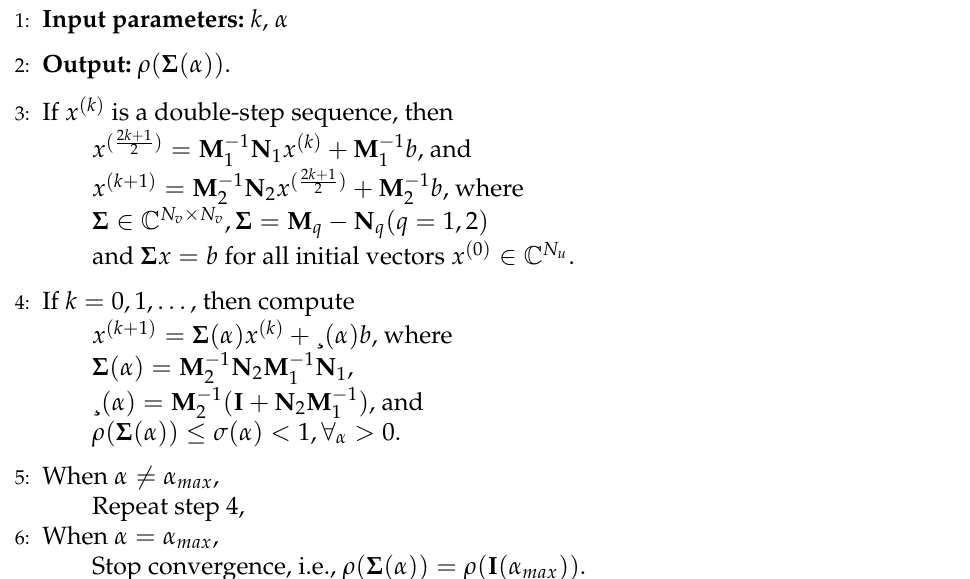
Algorithm 2 Proposed Double-Step Iterative Algorithm for User Vehicle